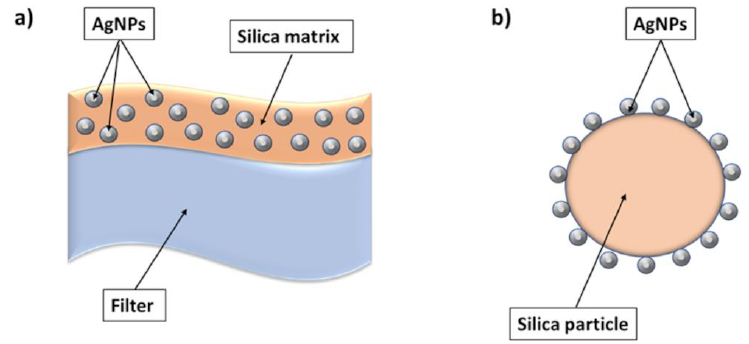
Figure 4. Comparison between two different silver–silica systems: ( a ) nanostructured silica composite coating containing silver nanoparticles; ( b ) silica particles decorated with silver nanoparticles .